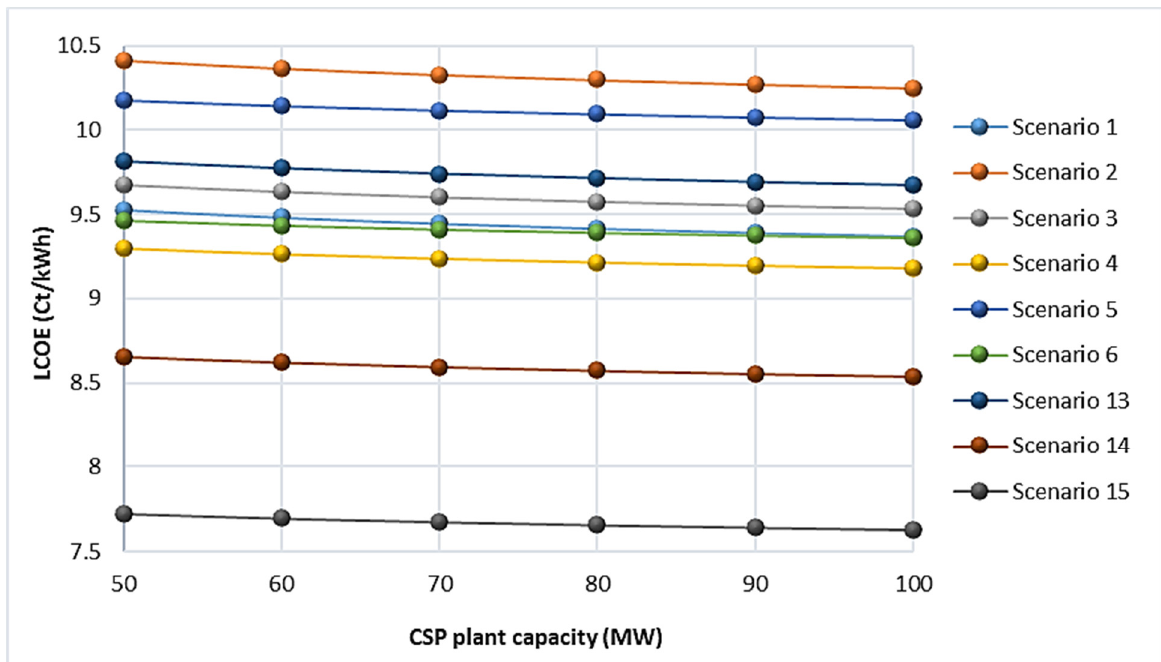
Figure 9. LOCE reduction with CSP plant capacity increment.